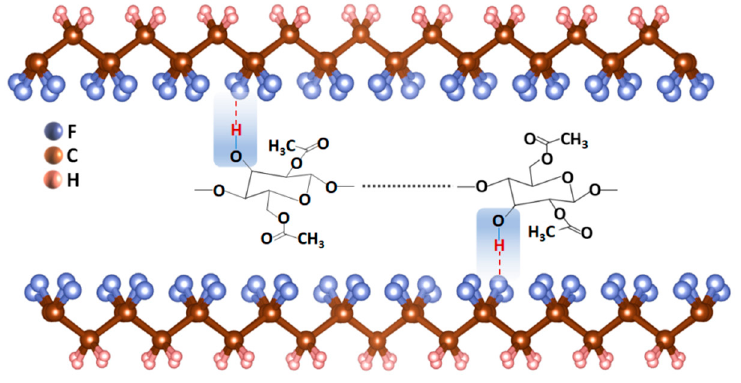
Figure 8. The chemical interactions between the CA and PVDF molecular chains.